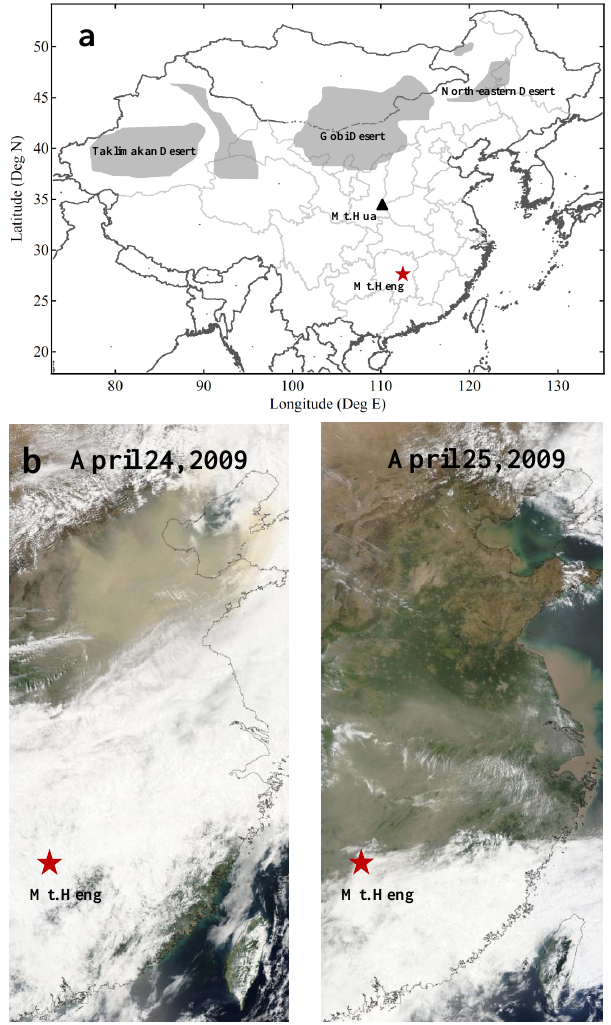
Fig. 1. (a) Map showing Mt. Heng and Mt. Hua. The major deserts in East Asia are marked by the shadows in the map. (b) MODIS true-color imagery of eastern China on 24 and 25 April, 2009.